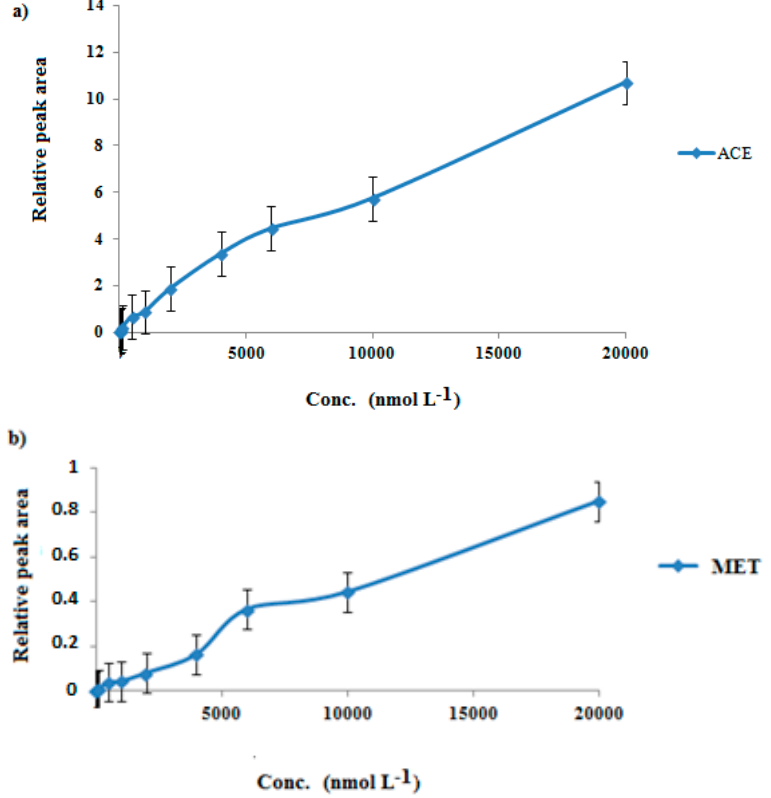
Figure 4. The capacity range of GO/PEG-stick for acebutolol ( a ) and metoprolol ( b ).